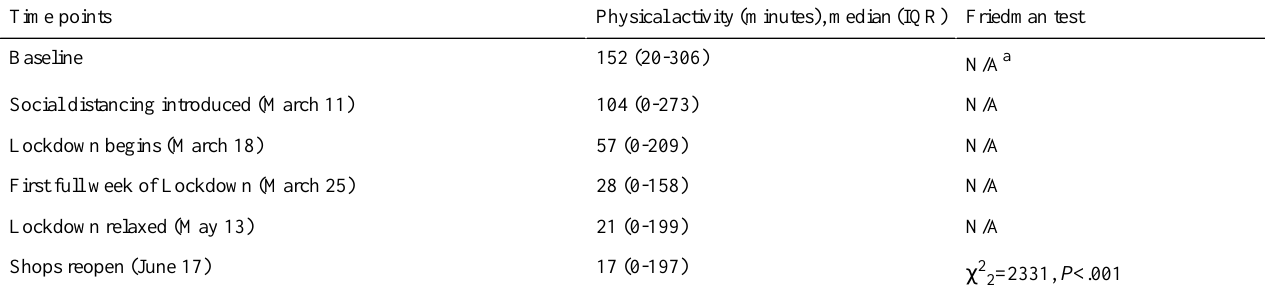
Table 3. Summary of physical activity at baseline, through lockdown, and beyond (January 22-June 17, 2020;